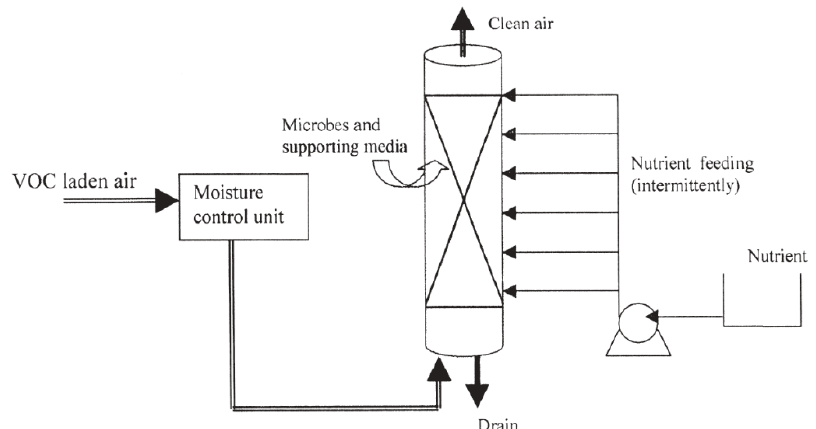
Figure 7. A simple schematic sketch of a bio-filtration system. Reprinted with permission from [26], 2000, Elsevier Ltd.